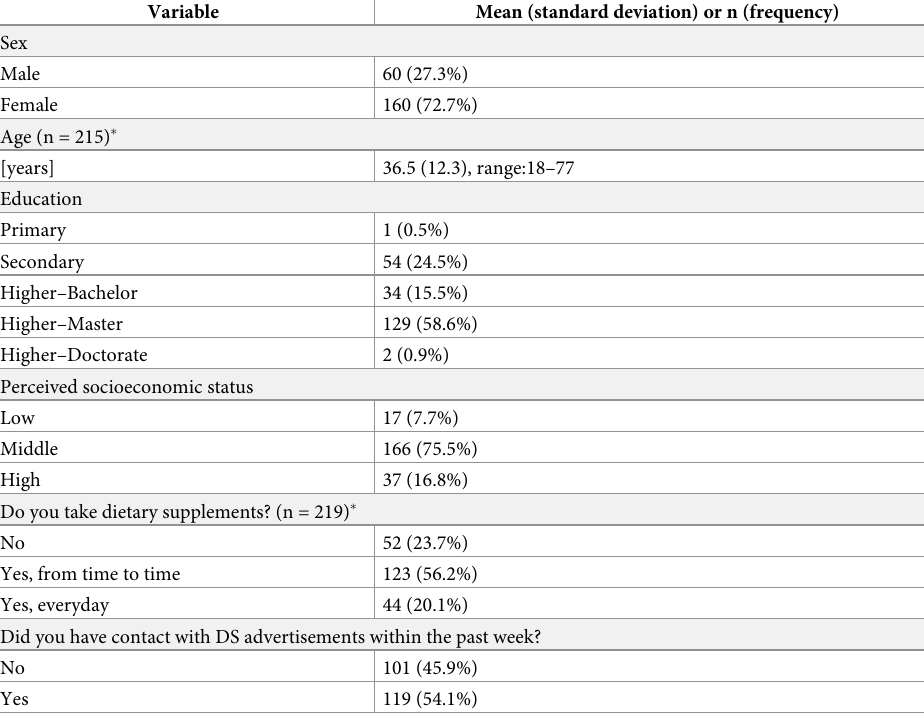
Table 1. The characteristics of respondents who participated in the testing stage of the development of questionnaires.